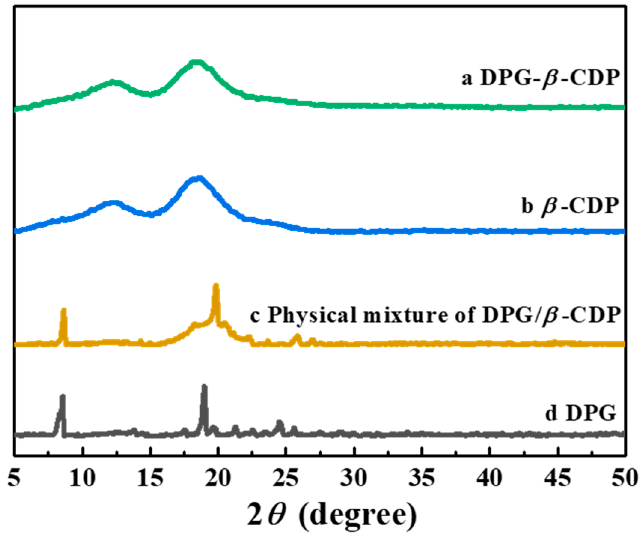
Figure 5. XRD patterns of DPG- β -CDP, DPG, and β -CDP, the physical mixture of DPG and β -CDP.